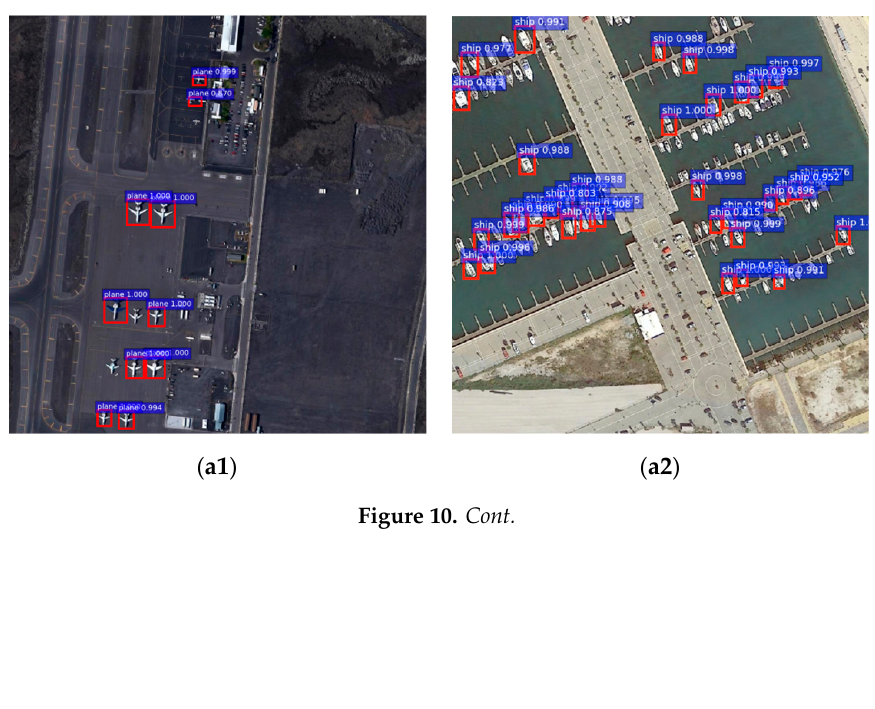
Table 5. Performance comparison of each part of the improved model on the MyPlane dataset.